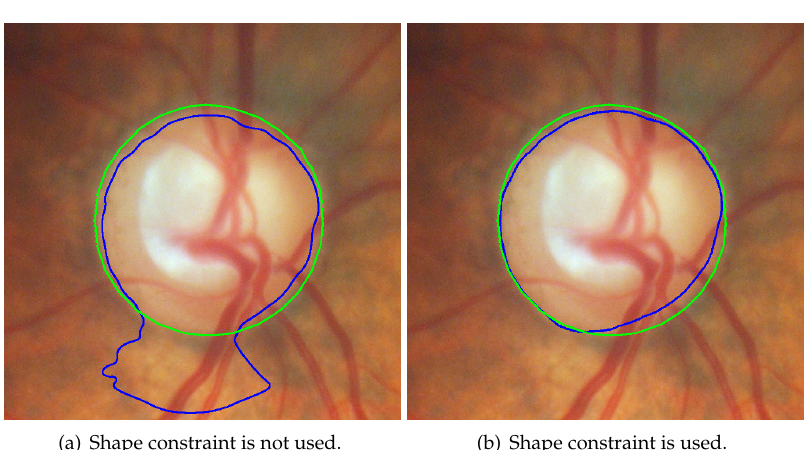
Figure 7. Comparison of shape-based term is used and not used. (blue contour: the segmentation result, green contour: the ground-truth of